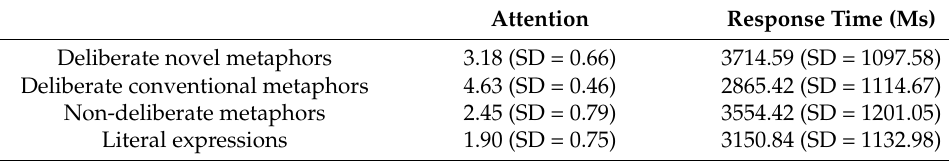
Table 1. Average scores of attention and respective response